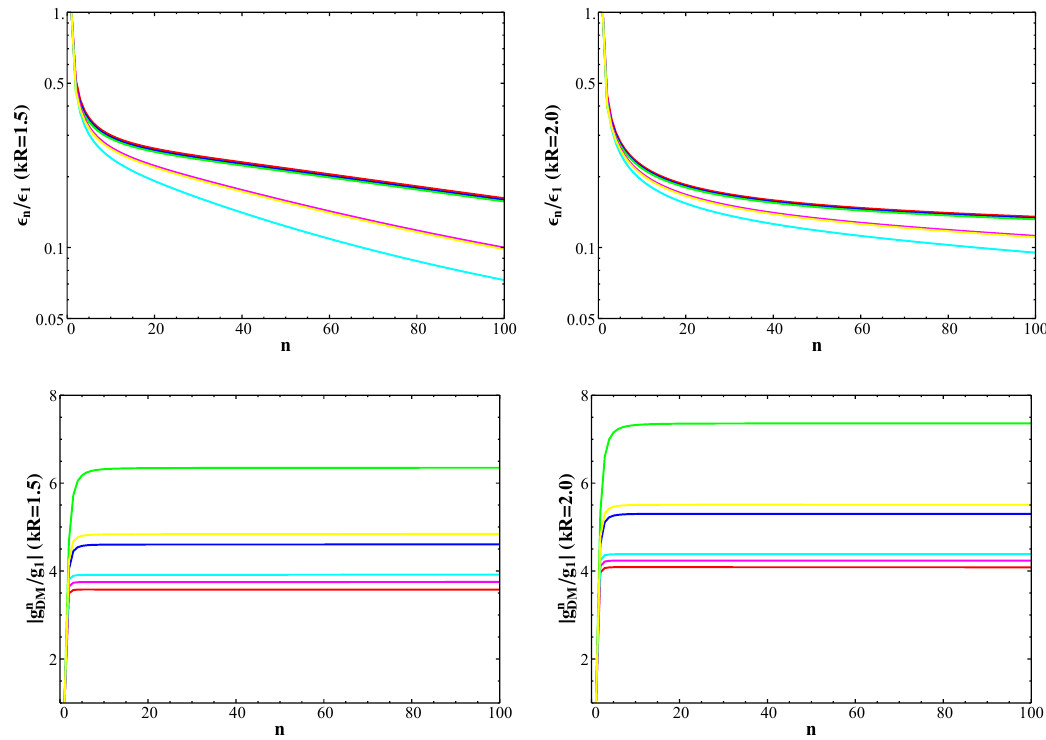
Figure 14 . (Top left) The ratio (cid:15) n /(cid:15) 1 , assuming kR = 1 . 5 , as a function of n for various choices of (( kR ) τ, a W ) =(1/2,1/2) [red], (1/2,1) [blue], (1/2,3/2) [green], (1,1/2) [magenta], (3/2,1/2) [cyan] and (1,1) [yellow], respectively. (Top right) The same as the top left, but assuming kR = 2 . 0 (Bottom left) The ratio g n /g D , assuming kR = 1 . 5 , as a function of n for various choices of DM (( kR ) τ, a W ) =(1/2,1/2) [red], (1/2,1) [blue], (1/2,3/2) [green], (1,1/2) [magenta], (3/2,1/2) [cyan] and (1,1) [yellow], respectively. (Bottom right) The same as the bottom left, but assuming kR = 2 . 0 . not directly comparable quantities, the significance of this diminished range is not